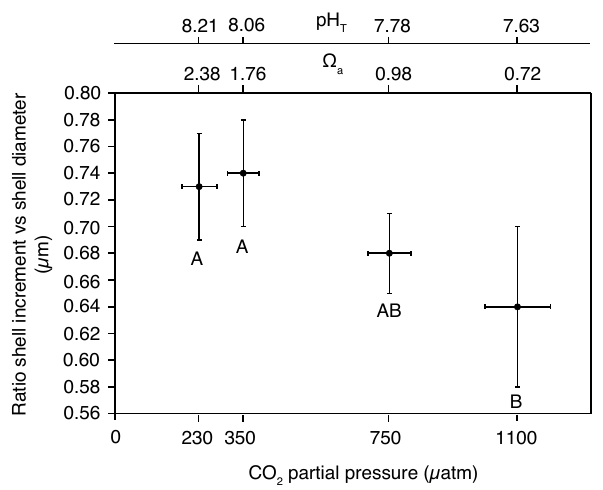
Fig. 9. Mean ratio of shell increment to diameter of Limacina he- licina after 29 days of incubation for the effect of p CO 2 . Vertical bars denote 0.95 confidence intervals for mean ratio while horizon- tal bars denote 0.95 confidence intervals for p CO 2 . Results from the Tukey HSD post-hoc test are depicted by letters with levels not connected by same letter being significantly different.